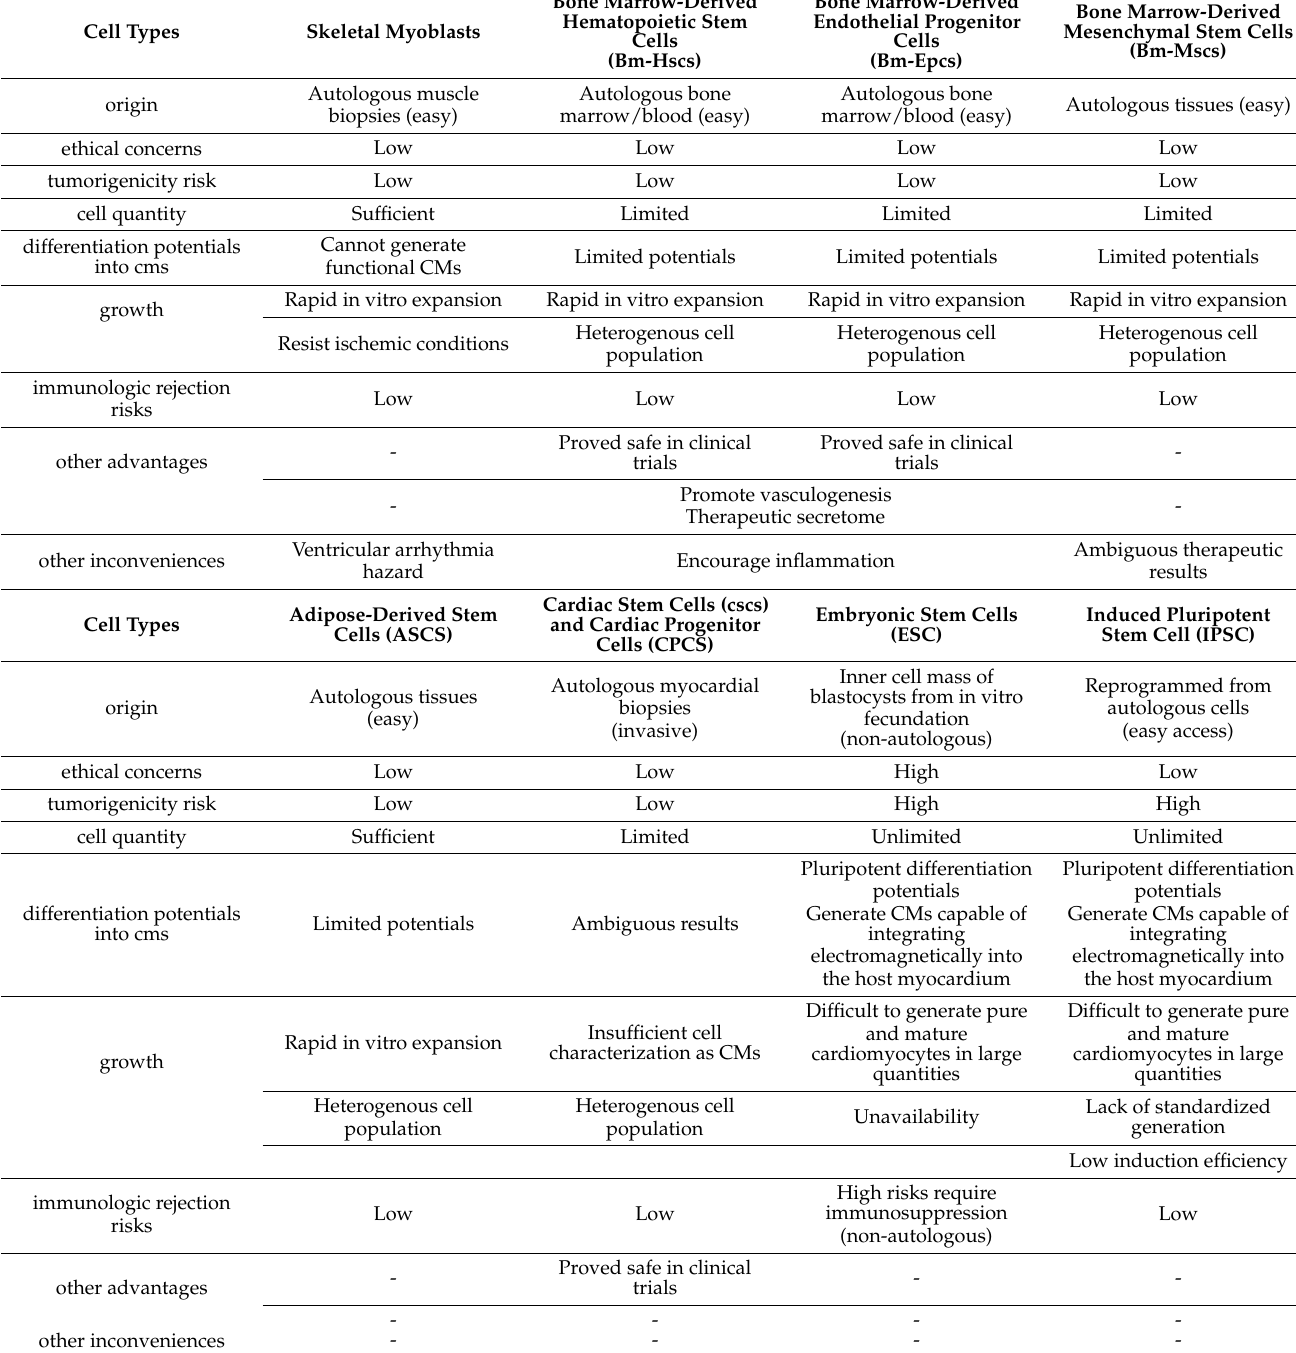
Table 1. Types of cells used in cardiomyocyte (CM) regeneration